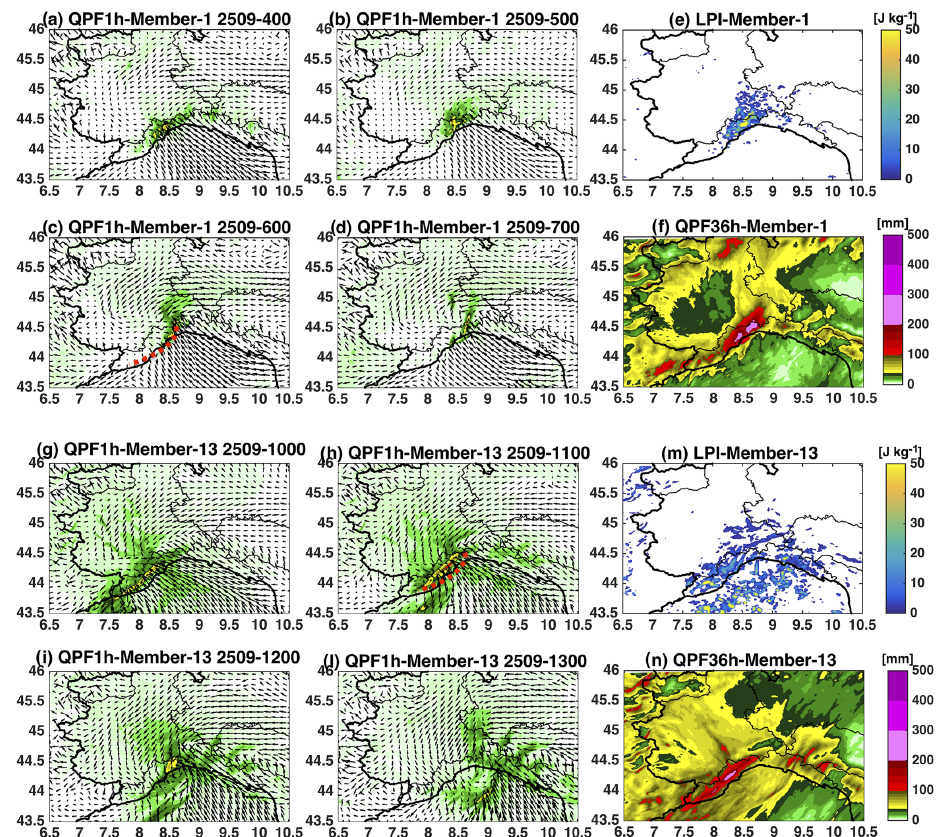
Figure 10. Panels (a–d) and (g–l) show the hourly QPF and 10m wind fields corresponding to the period with the minimum divergence values in Fig. 9 for members 1 and 13 (the convergence line trace in the most active phase is red dashed). Panels (e–f) and (m–n) show the Lightning Potential Index accumulated over the same 4h period and the 36h QPF respectively for members 1 and 13.